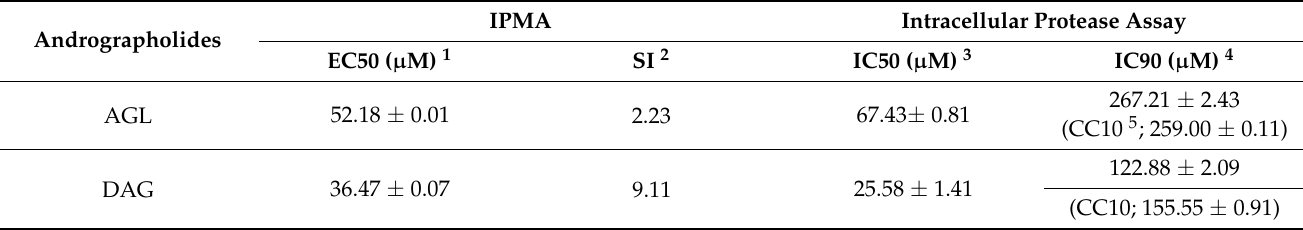
Table 2. Effective concentrations (EC50), selective indices (SI), and protease inhibition concentrations (IC50) by intracellular protease assay of AGL, DAG, and NEO.